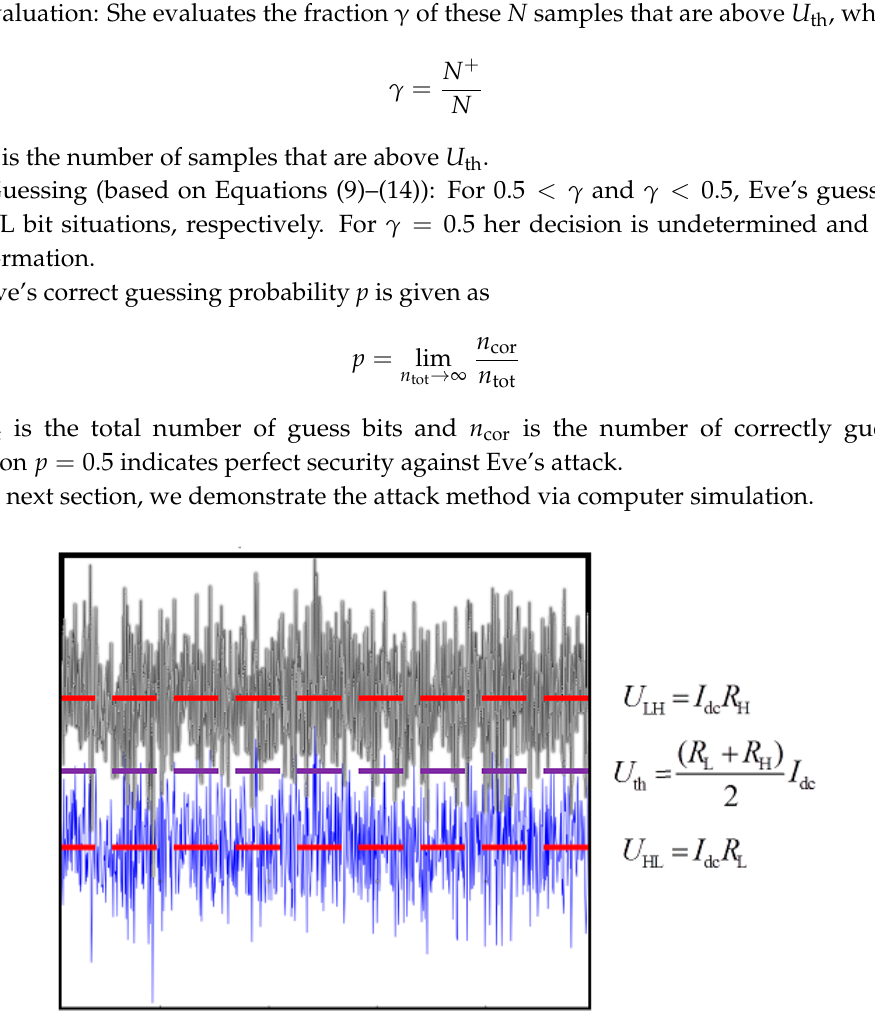
Figure 3. Eve’s threshold scheme to guess the bit situation LH versus HL.